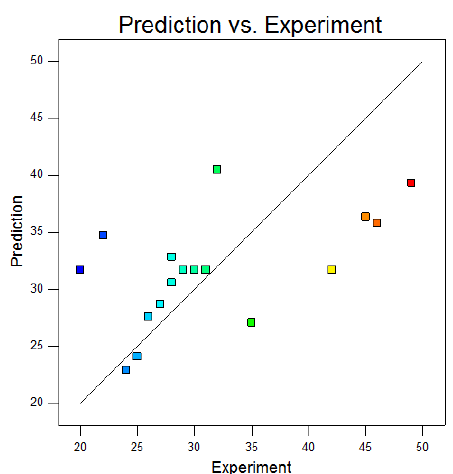
Figure 11. Comparison results between predicted impact absorption energy of model and actual value.